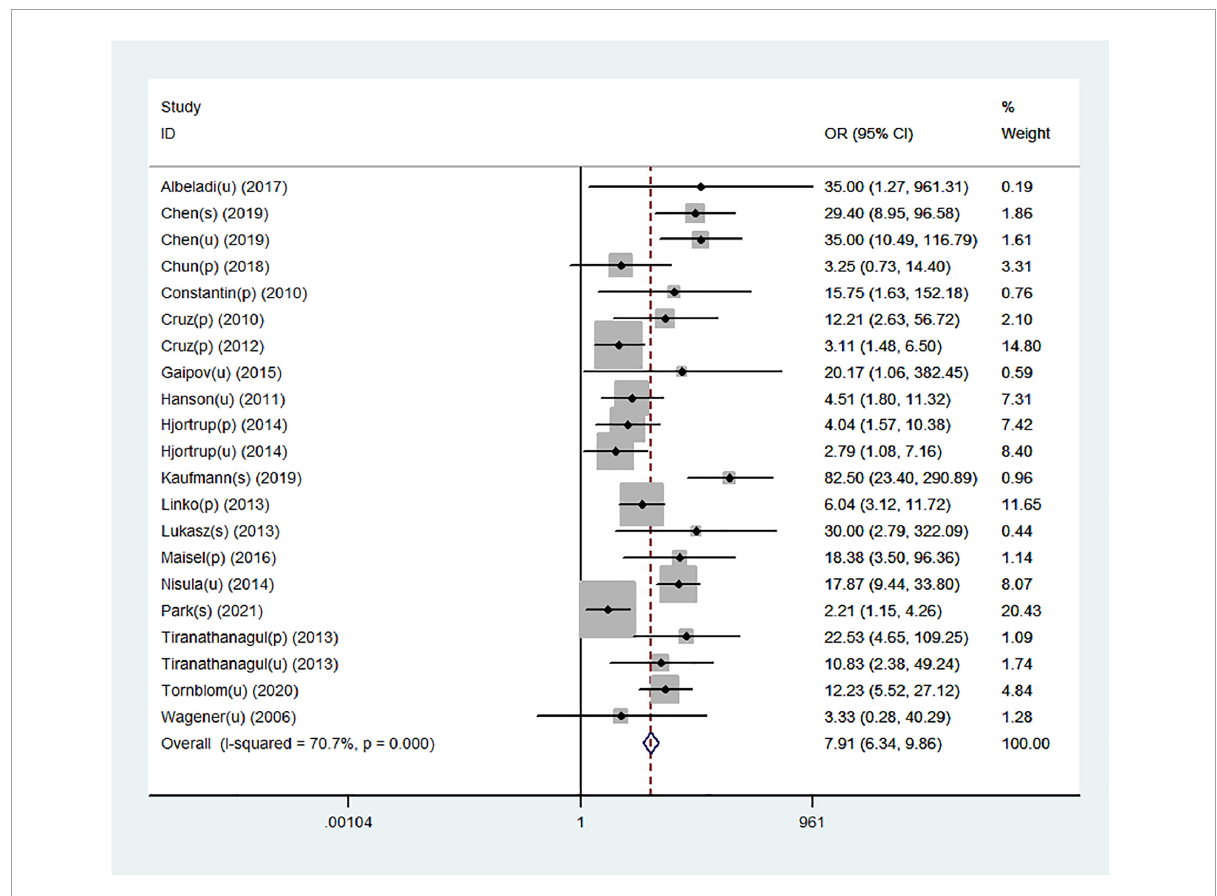
FIGURE4 Forest plot for the predictive value of NGAL for AKI requiring RRT from plasma/serum and urine